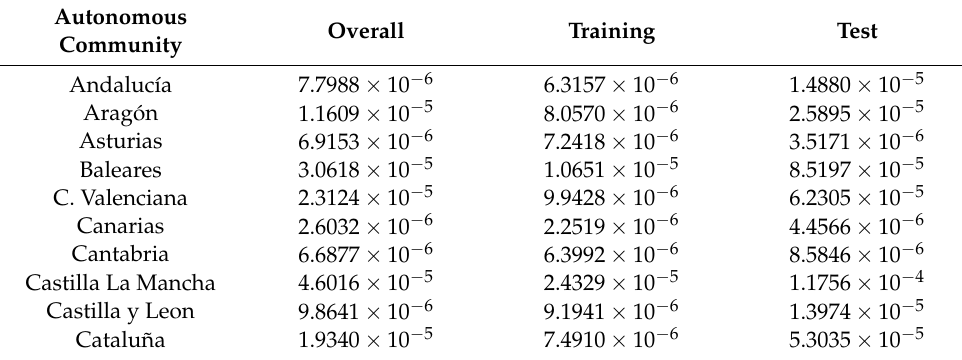
Table A1. LSTM errors (RSME) per Autonomous